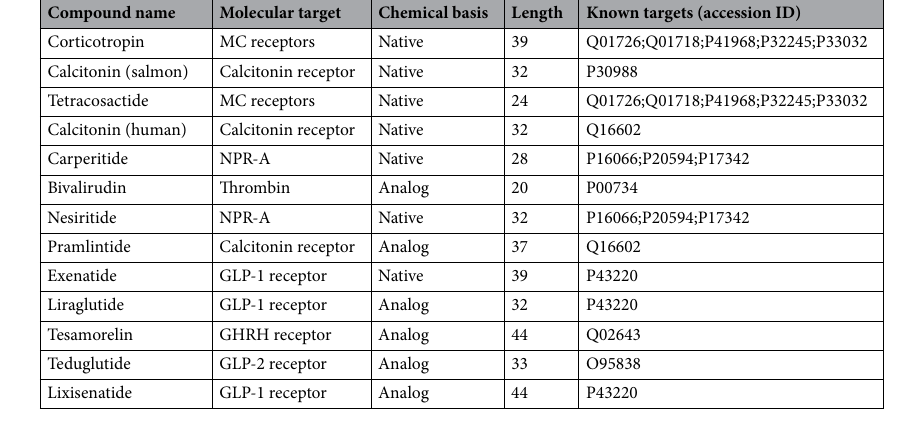
Table 1. FDA-approved peptides evaluated in this study.